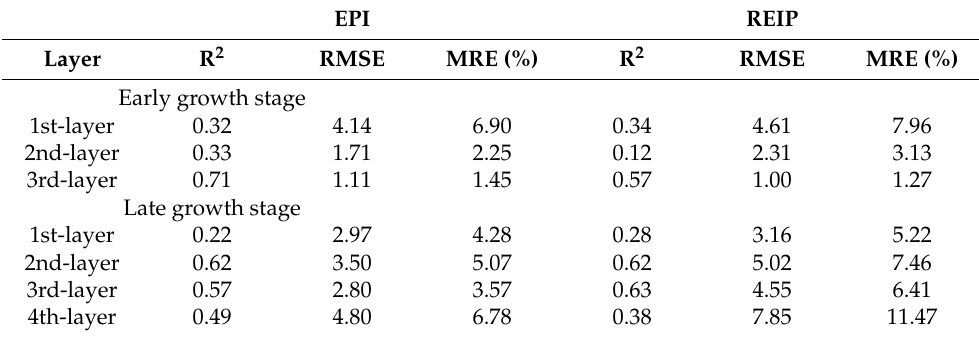
Table 5. Accuracy evaluation results.